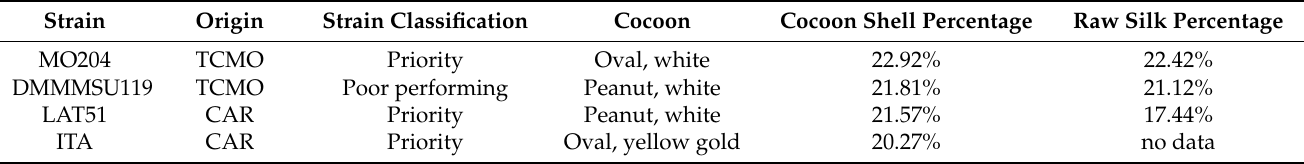
Table 2. Characteristics of silkworm strains used in the study.